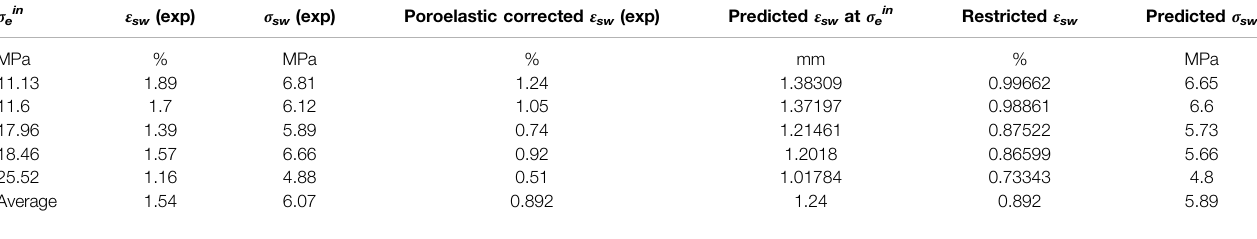
Table A1 | Comparison of model prediction with experimental data on swelling stresses measured by Zhang (2019) for VD SWy-1 samples exposed to CO2 pressure at 10 MP at 50 °